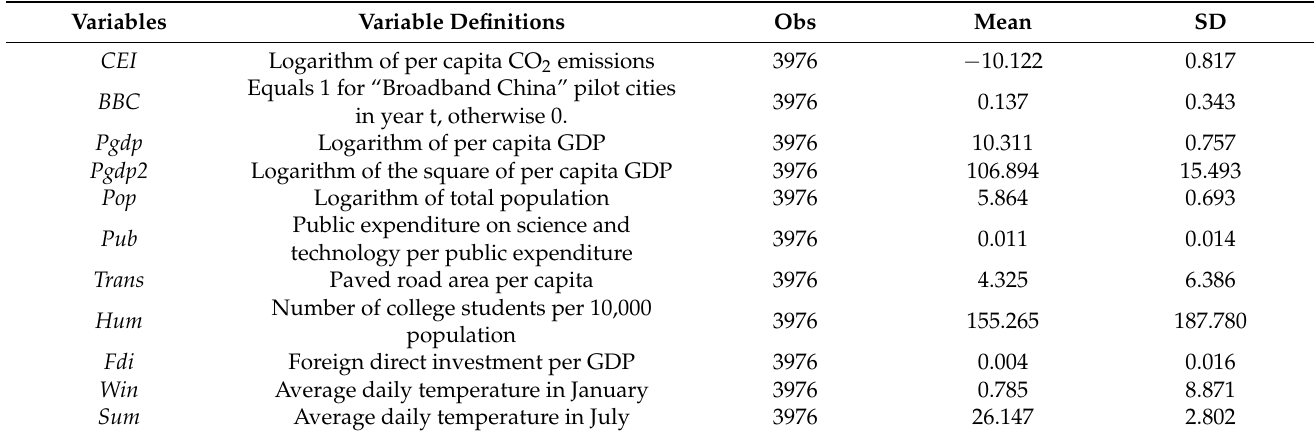
Table 1. Variables’ definitions and descriptive